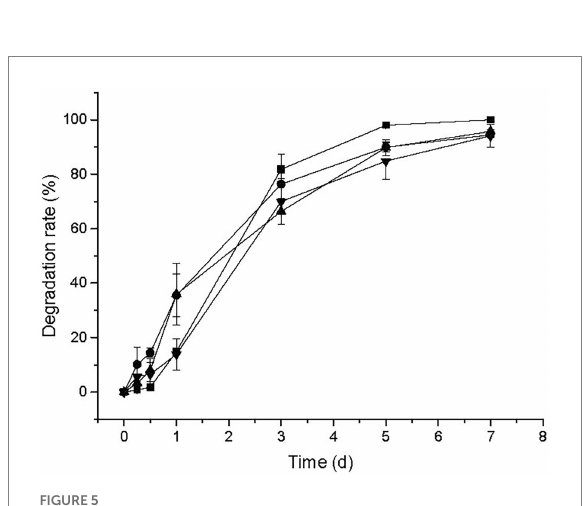
FIGURE 5 Degradation of other sulfonylurea herbicides including nicosulfuron ( ▪ ), halosulfuron methyl (•), pyrazosulfuron ( ▴ ), and ethoxysulfuron ( ▾ ) by strain CD3.